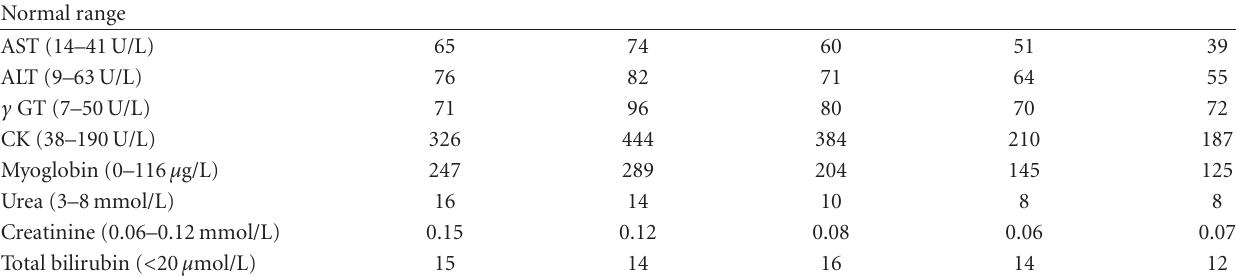
Table 1: Serum values of some parameters during 5